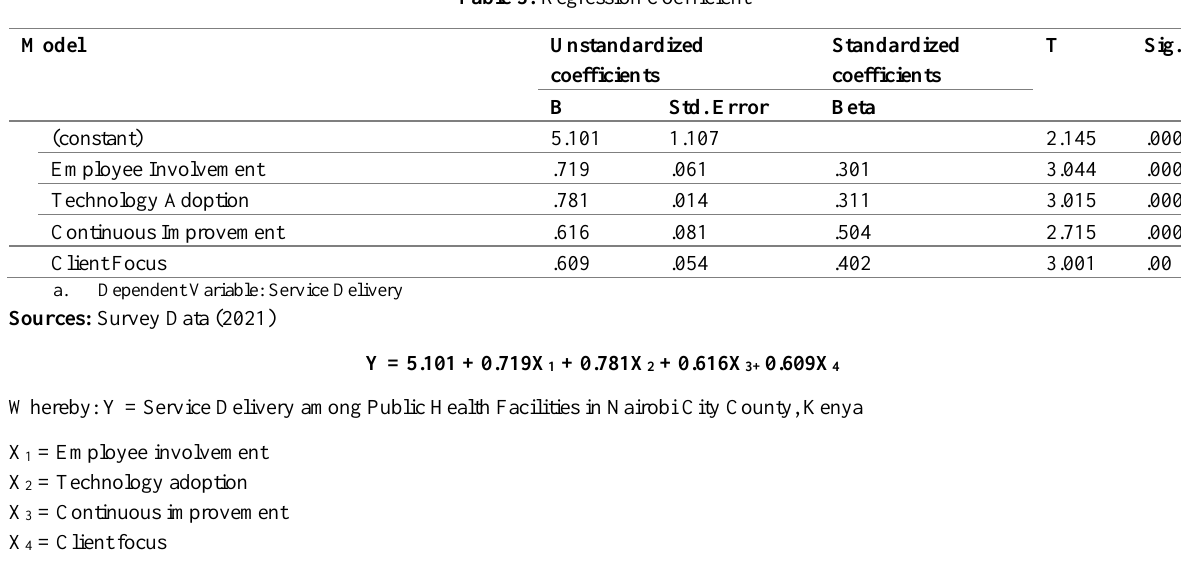
Table 3: Regression